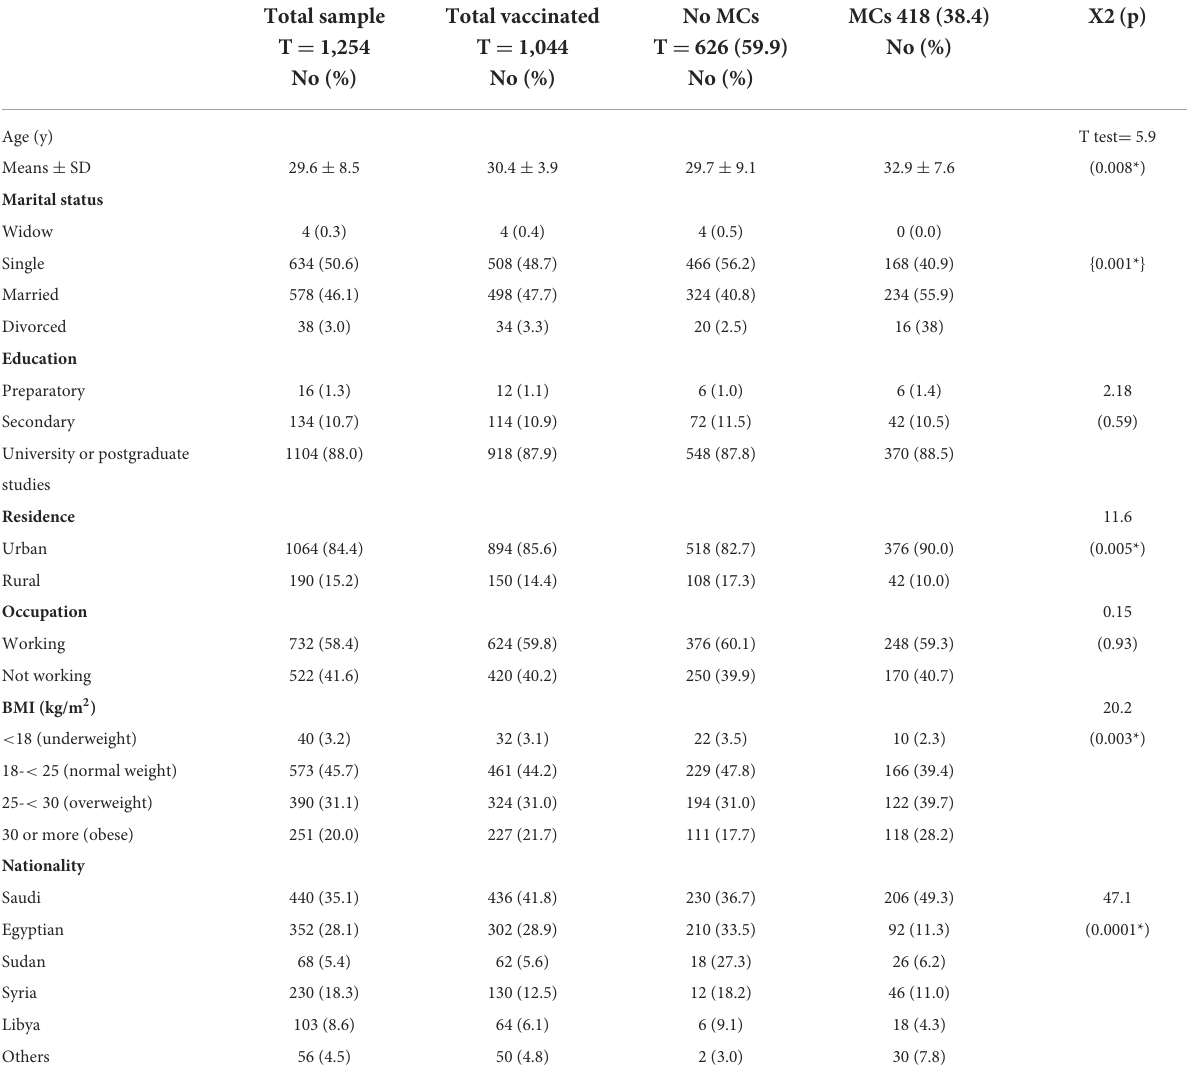
TABLE 1 Demographic characteristics and its relationship with the MCs among COVID-19 vaccinated